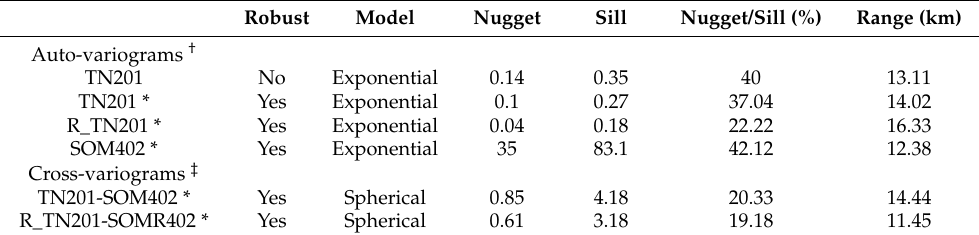
Table 4. Parameters of the auto- and cross-variograms for different kriging